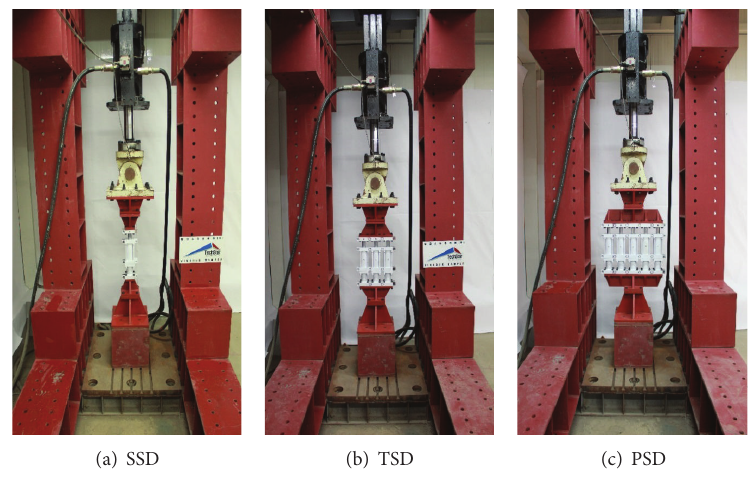
Figure 3: Dynamic loading